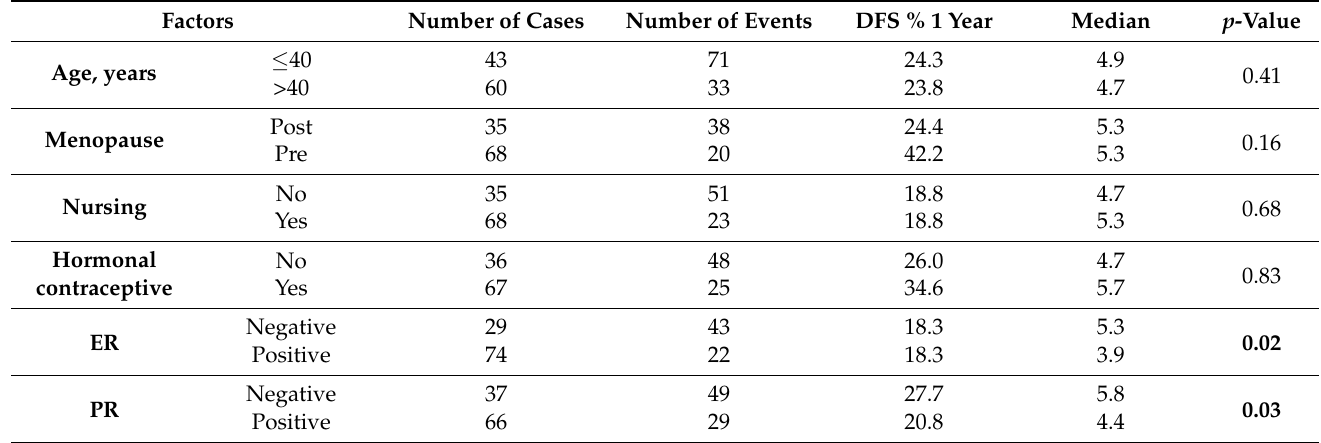
Figure 2. Kaplan Meier plots of survival analysis in carriers of all BRCA1/2 variants. ( a ) Disease-free survival (DFS), ( b ) Recurrence-free survival (RFS), ( c ) Overall survival (OS), ( d ) Metastasis-free survival (MFS). p -values calculated by log-rank test (considering whole follow-up period). Table 2. Univariate analysis for disease-free survival (DFS).